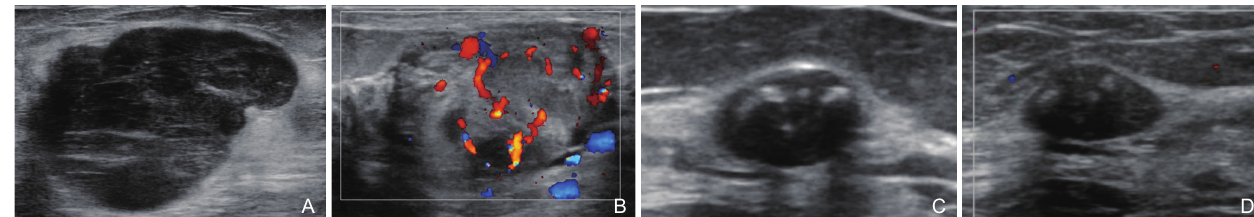
A Figure 1 The B-mode US images (A, C) and the color Doppler US images (B, D). (A-B) Phyllodes tumor, breast mass presents a peripheral echogenic halo with vessels in rim and internal vascularity; (C-D) Fibroadenoma, mass has calcifications within it in B-mode US, no vascularity in color Doppler US.